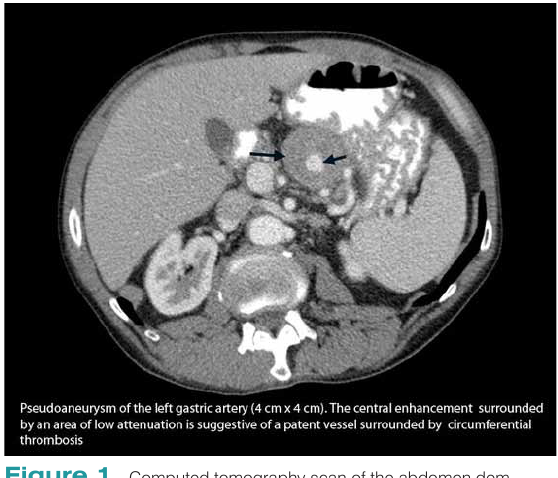
Figure 1. Computed tomography scan of the abdomen dem- onstrating pseudoaneurysm of the left gastric artery, measuring 4 cm x 4 cm, with circumferential thrombosis